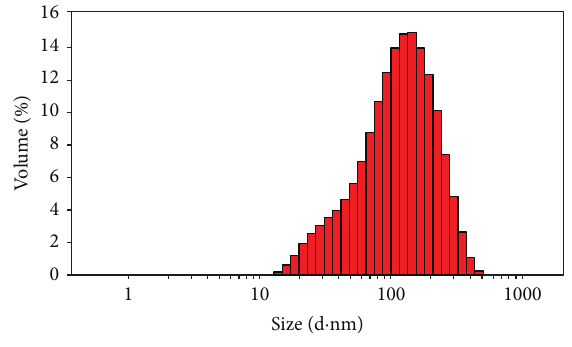
Figure 3: Size distribution of the NS